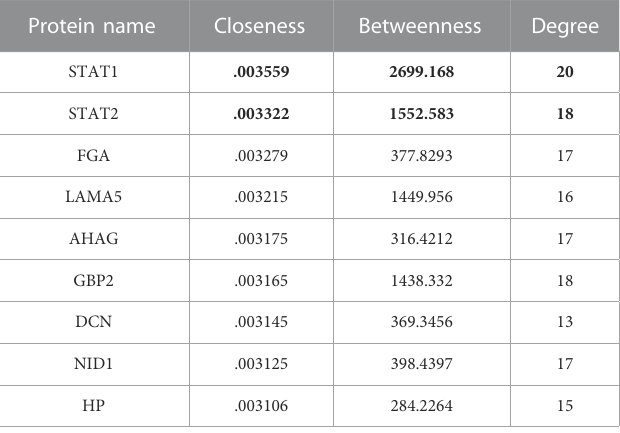
TABLE 1 The central proteins in the PPI network screened using CentiScaPe analysis. Protein